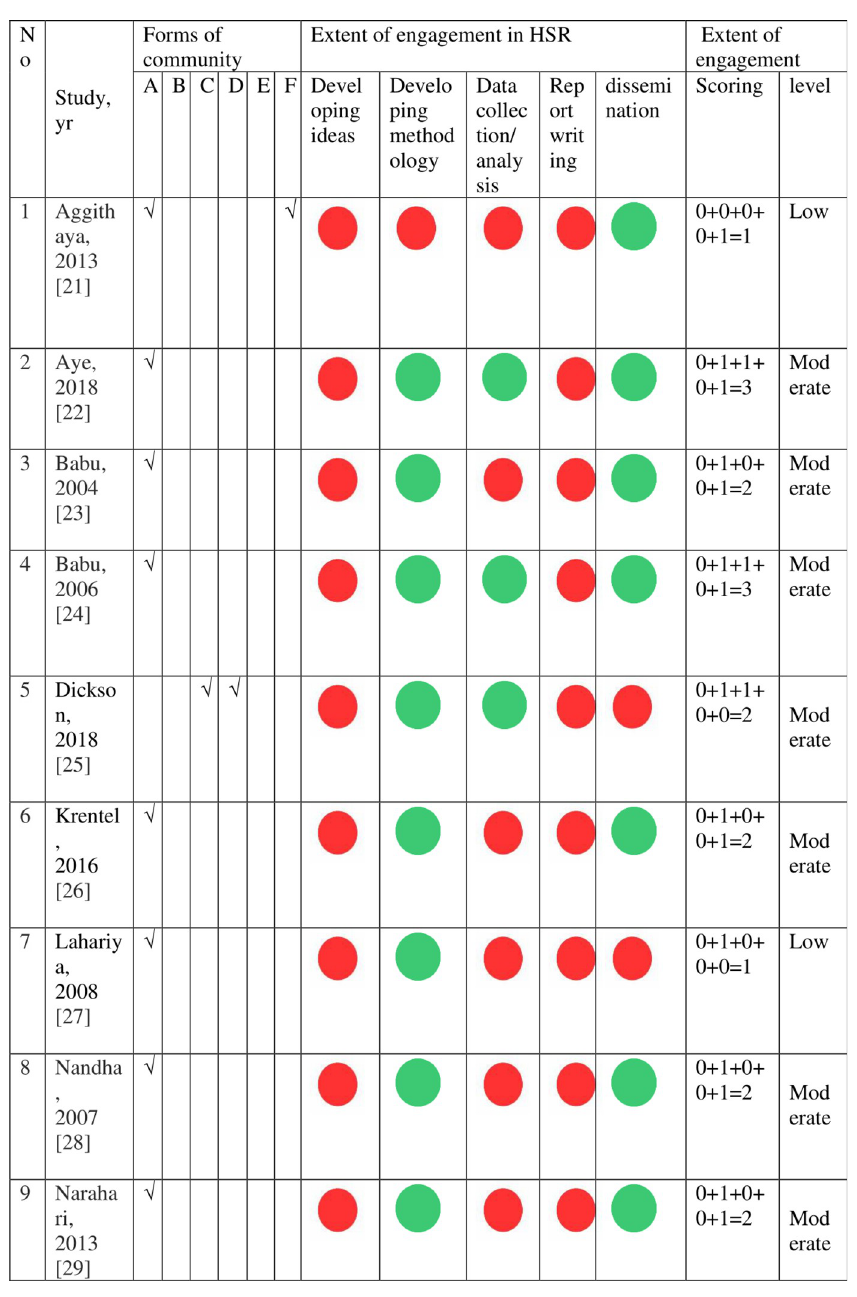
Fig 3. Various forms of community and extent of engagement (N = 16